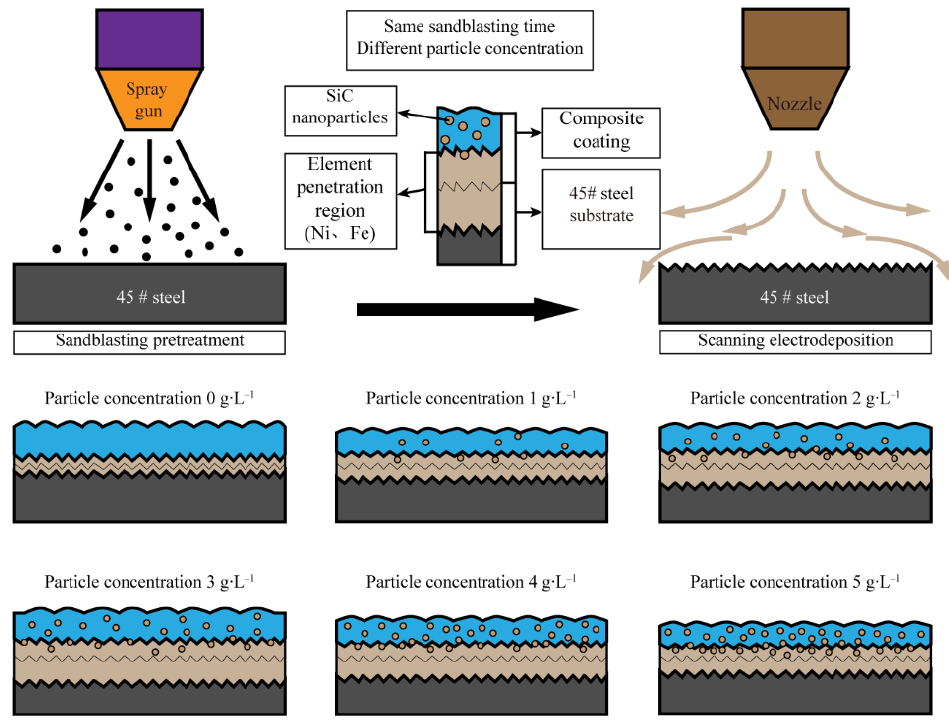
Figure 6. Schematic of the elemental penetration mechanism of the composite coatings with different particle concentrations prepared on 45 steel substrates through scanning electrodeposition.